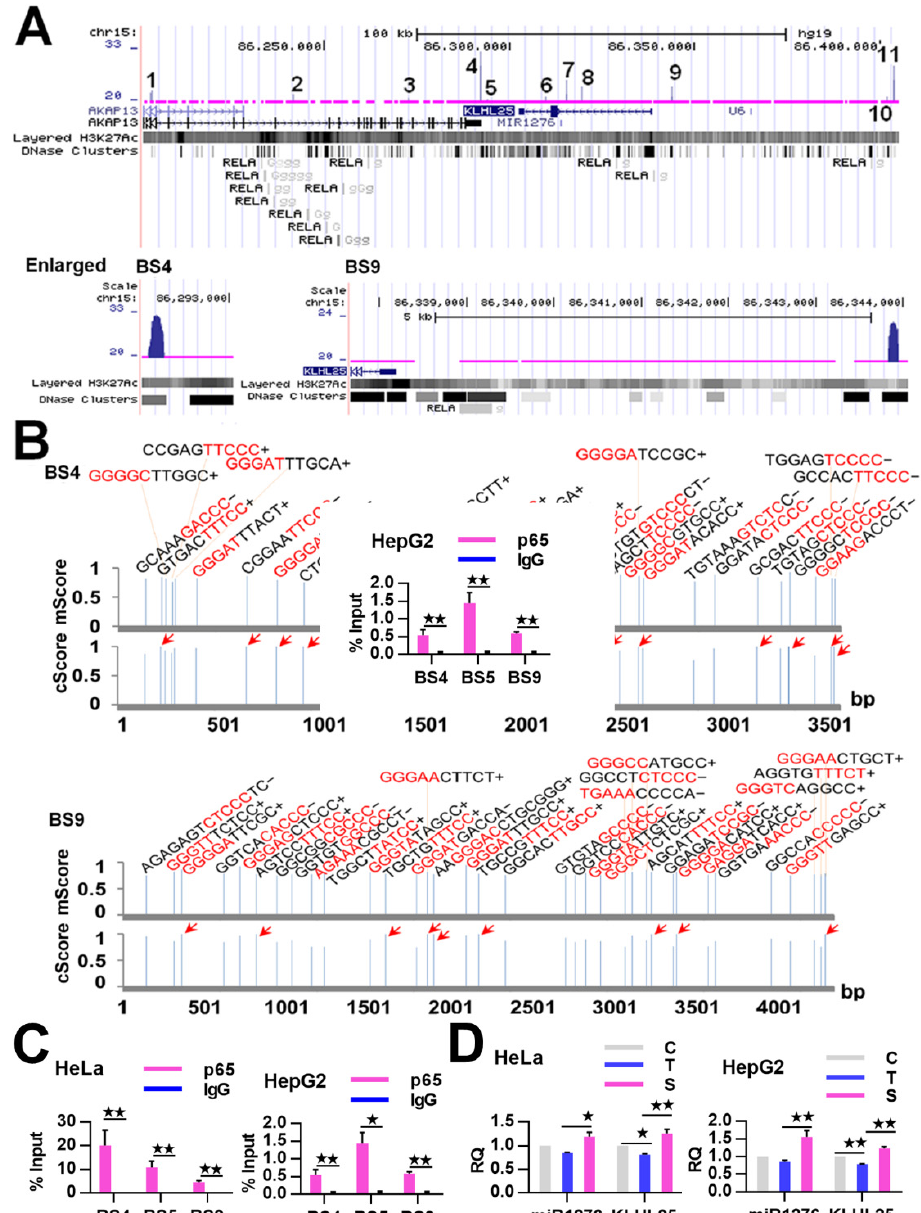
Figure 4. Binding and regulation of KLHL25 / miR1276 by NF- κ B. ( A ) NF- κ B-BSs (i.e., ChIP-Seq peaks; labeled with numbers) assigned to the KLHL25 / miR1276 genes in TNF α -treated HeLa cells. The magnified BS4 and BS9 are put on the bottom. ( B ) The predicted κ Bs in BS4 and BS9. The relative position, sequence and match score of κ Bs in the BSs are shown. Five most conserved bases in the core match analysis are shown in red. The κ Bs with a core score of 1 are highlighted with arrows. mScore, matrix match score; cScore, core match score. ( C ) ChIP-qPCR detections of three BSs assigned to the KLHL25 / miR1276 genes in TNF α -treated HeLa and HepG2 cells. The data are presented as the means ± SD from at least three replicates. The significance of the di ff erences was analyzed by Student’s t-test. * p < 0.05; ** p < 0.01. ( D ) Expression of miR1276 and KLHL25 in HeLa cells and HepG2 cells. GAPDH or U6 was used as the endogenous control in the qPCR detection to normalize the target genes. Relative quantification (RQ) is the expression of detected gene normalized to that of GAPDH or U6 in each sample and presented relative to the control cells. The data are presented as the means ± SEM from three independent experiments with three replicates in each test. C, control cells; T, TNF α -treated cells; S, RelA siRNA and TNF α co-treated cells. The significance of the di ff erences was analyzed by one-way ANOVA. * p < 0.05; ** p < 0.01.